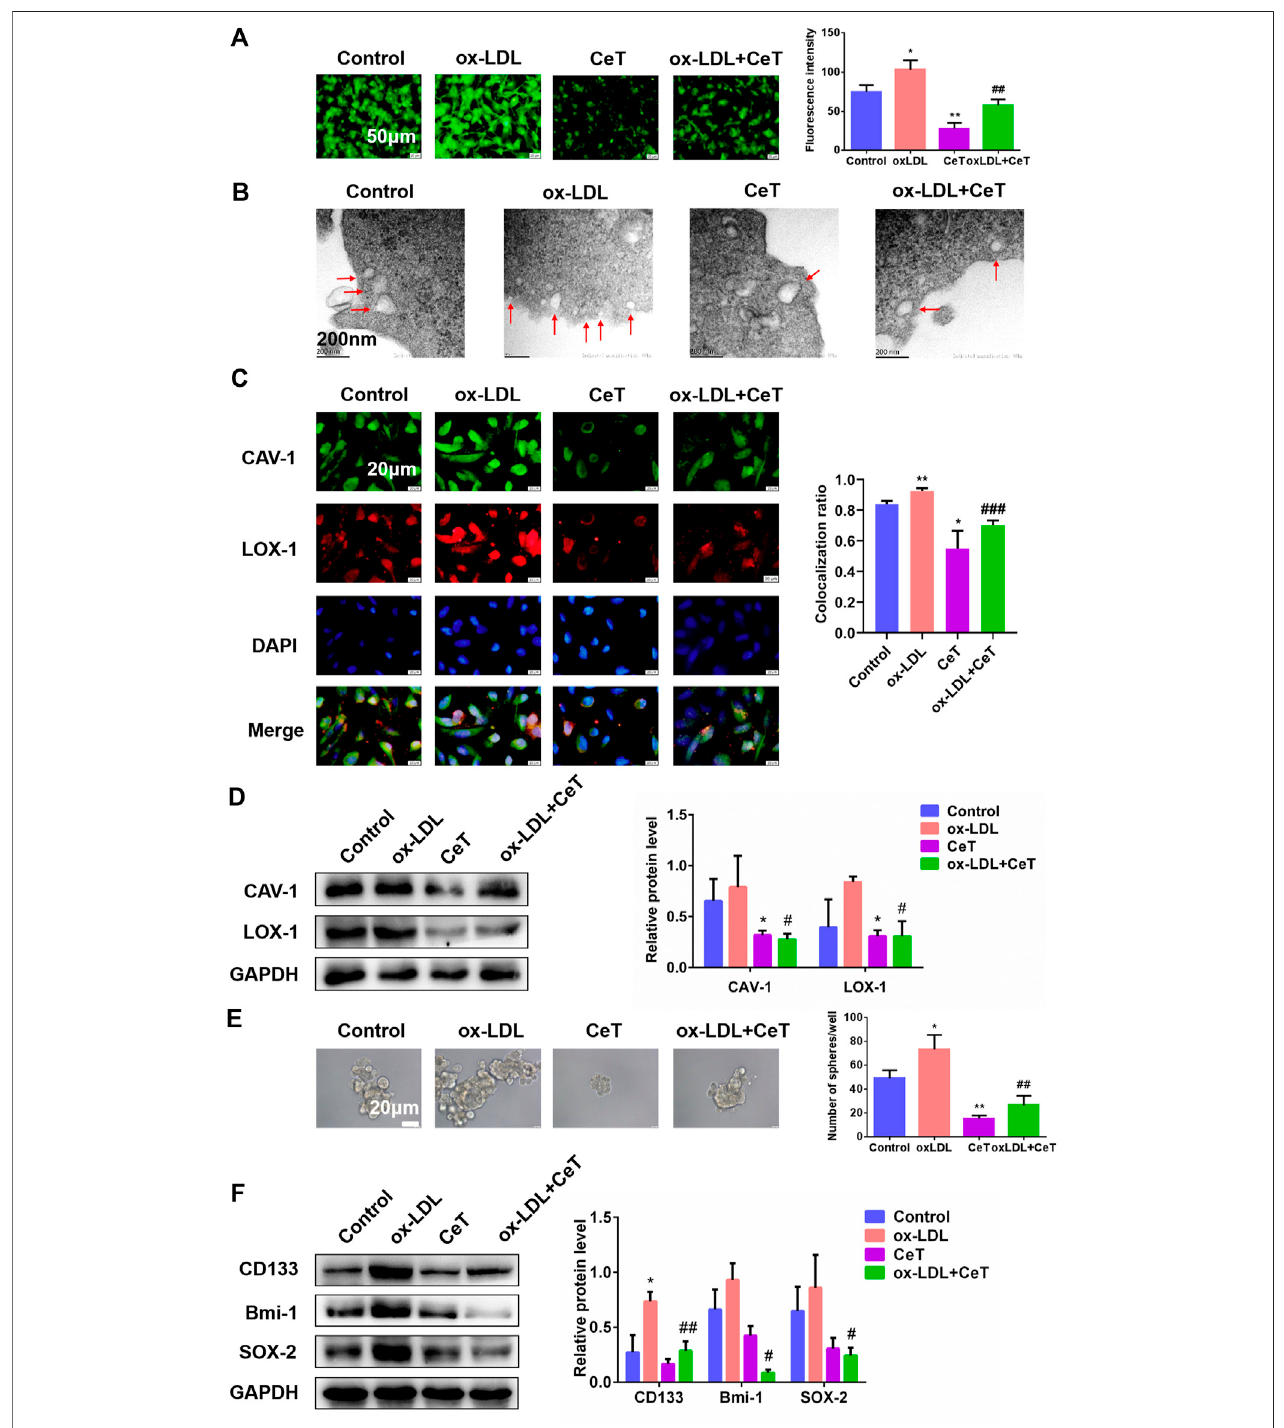
FIGURE 4 | Celastrol repressed lipid accumulation and stemness properties induced by ox-LDL (A) The BODIPY fl uorescence intensity of 786-O cells in the absenceandpresenceofox-LDLorCeTwasobservedbyusing fl uorescentmicroscope.Scalebar:50 μ m (B) TEMshowedtheformationofcaveolaein786-Ocells(red arrows). Scale bar: 200 nm (C) Co-localization of CAV-1 and LOX-1 in 786-O cells treated with ox-LDL or CeT. Scale bar: 20 µm. The Pearson ’ s correlation wasshown in bar graph from three independent experiments (D) The expression of CAV-1 and LOX-1 in 786-O cells was detected by western blotting (E) Representative imageandquanti fi cationoftumorspheresproducedby786-OcellswithorwithoutCeTandox-LDL.Scalebar:20 µm (F) Westernblottingwasperformedtodetermine the expression ofCD133, Bmi-1,SOX-2. The datawereshown asthe mean ± SD ofthree replicates. * p < 0.05,** p < 0.01,*** p < 0.001vs. thecontrolgroup; # p < 0.05, ## p < 0.01 vs. the CeT